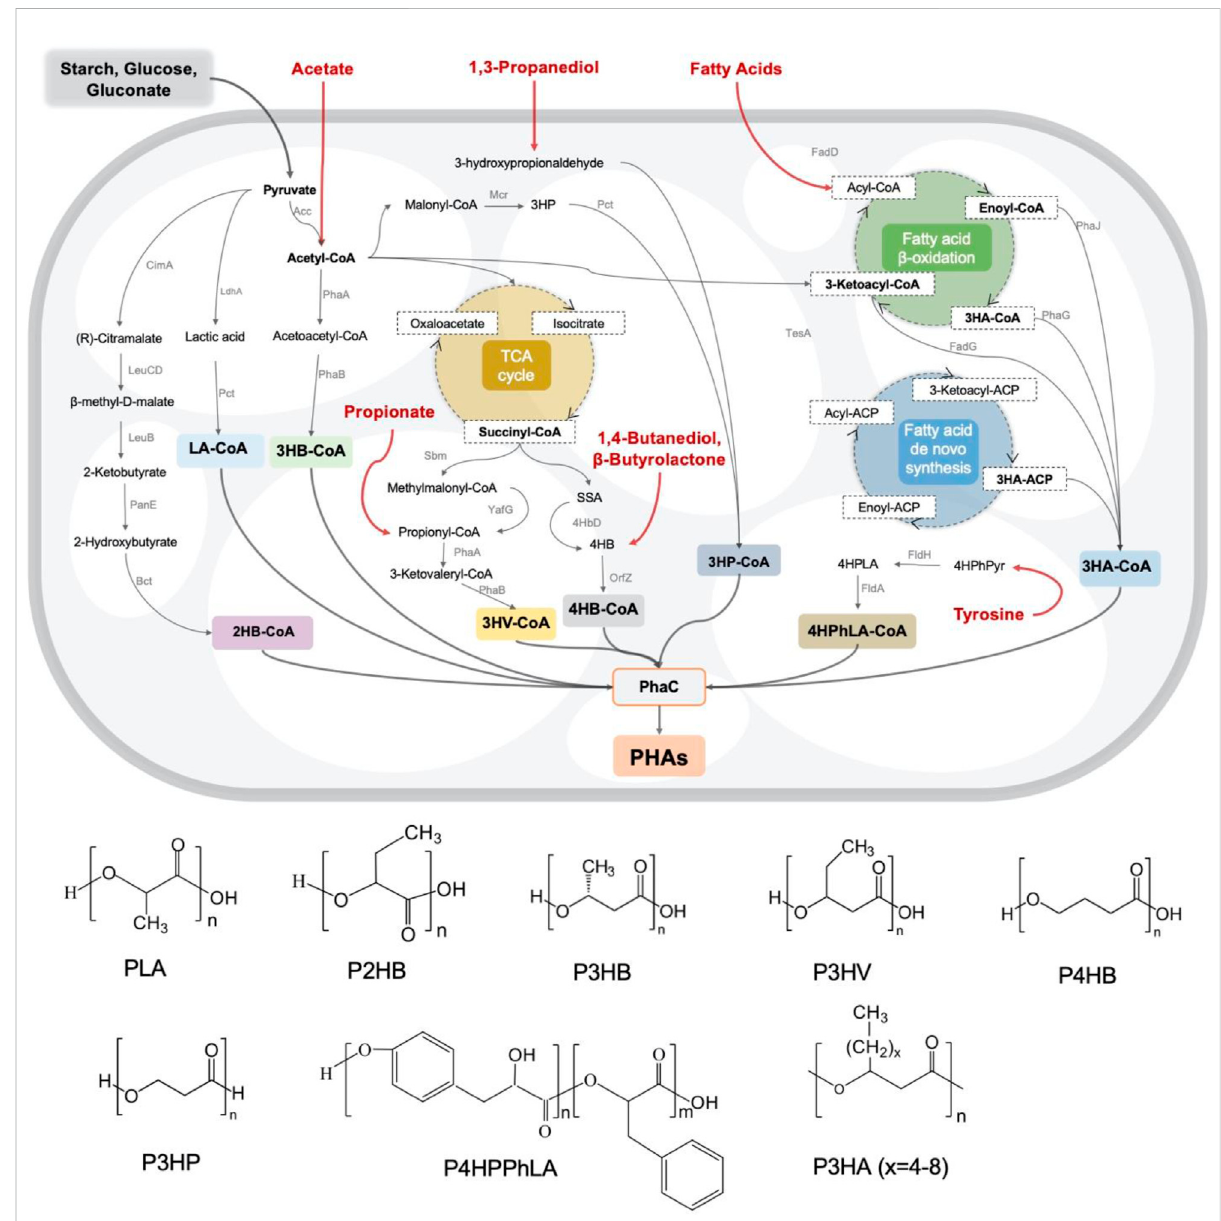
FIGURE 1 Metabolic pathways and monomer structures of different microbial synthesized